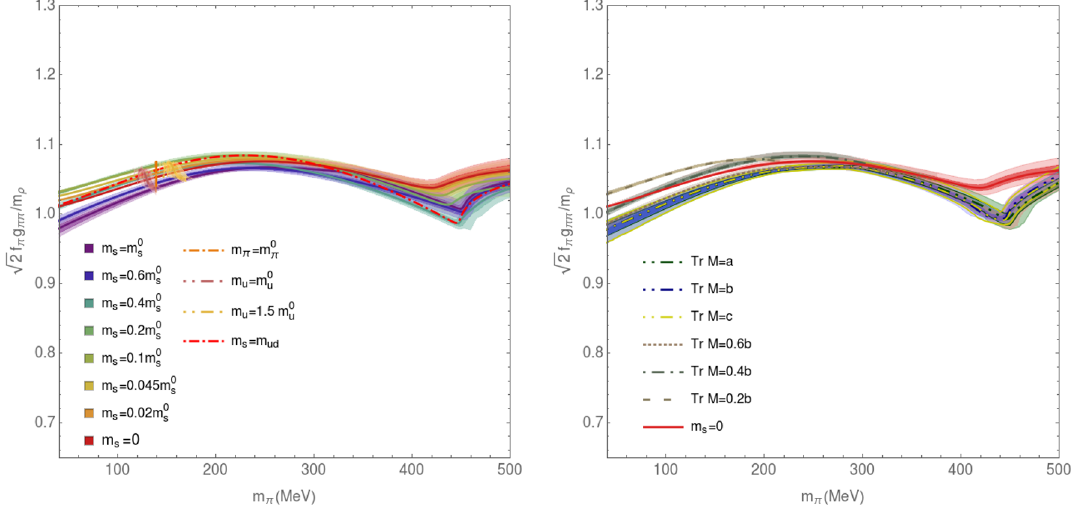
p Figure 37 . The quantity 2 f (cid:25) g (cid:25)(cid:25) =m (cid:26) as a function of m (cid:25) for m s = k; m u = c; m (cid:25) = m 0 m s = m u trajectories (left), and over Tr M = C (right). Deviations from one re(cid:13)ect violations of the KSFR